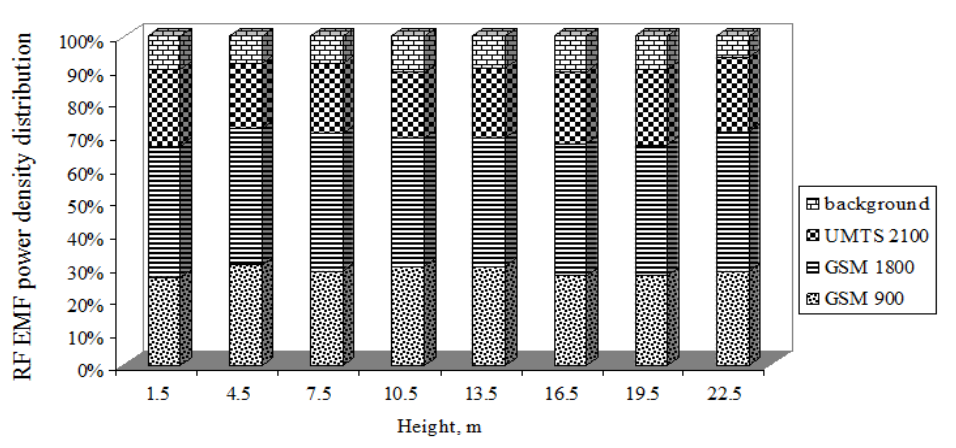
Figure 14. Contributions of different antenna types to the total exposure.